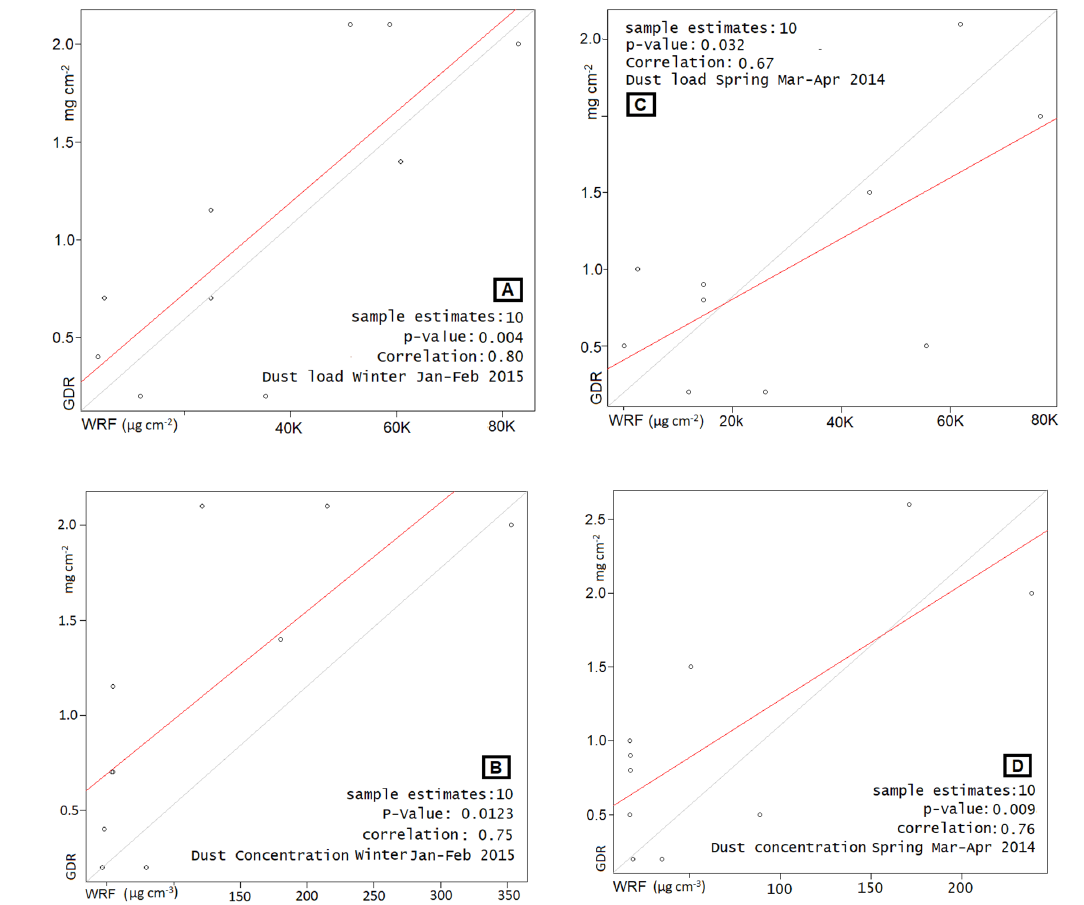
Figure 14. Correlation plot of the WRF-Chem versus the GDR observation. Scatter plot between GDRs (observation) and WRF-Chem (model output) illustrates that for the dust load ( A ) and dust concentrations ( B ) in January 2015 on the left and the correlation coefficient value in spring 2014 for the dust load ( C ) and concentration ( D ) on the right side.